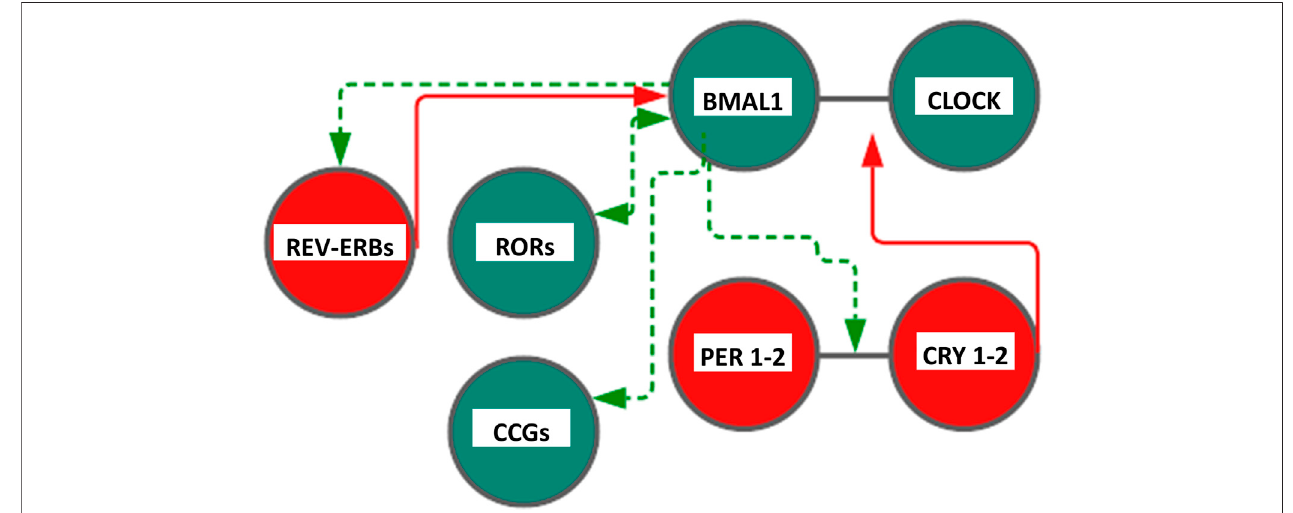
FIGURE 1 | Scheme representing the core cogs of the mammalian molecular clockwork. The transcriptional/translational feedback loop entails a positive (activating) limb operated by BMAL1:CLOCK heterodimer transcriptional activity and a negative limb (inhibitory) operated by the PER:CRY heterodimer. Rhythmic BMAL1 expression is driven by an additional loop through the nuclear receptors REV-ERBs and RORs. Color code: red circles and lines indicate inhibitory activity, and green circles and lines indicate activating function. CLOCK — Circadian Locomotor Output Cycles Kaput), BMAL1 — Brain and Muscle Arnt-Like protein 1, PER1- 2 — (Period proteins), CRY1-2 — Cryptochrome proteins , REV-ERBs — Reverse transcript of erythroblastosis gene α , β , and RORs — RAR-related orphan receptor α , β , and γ proteins. See text, for more explanations.